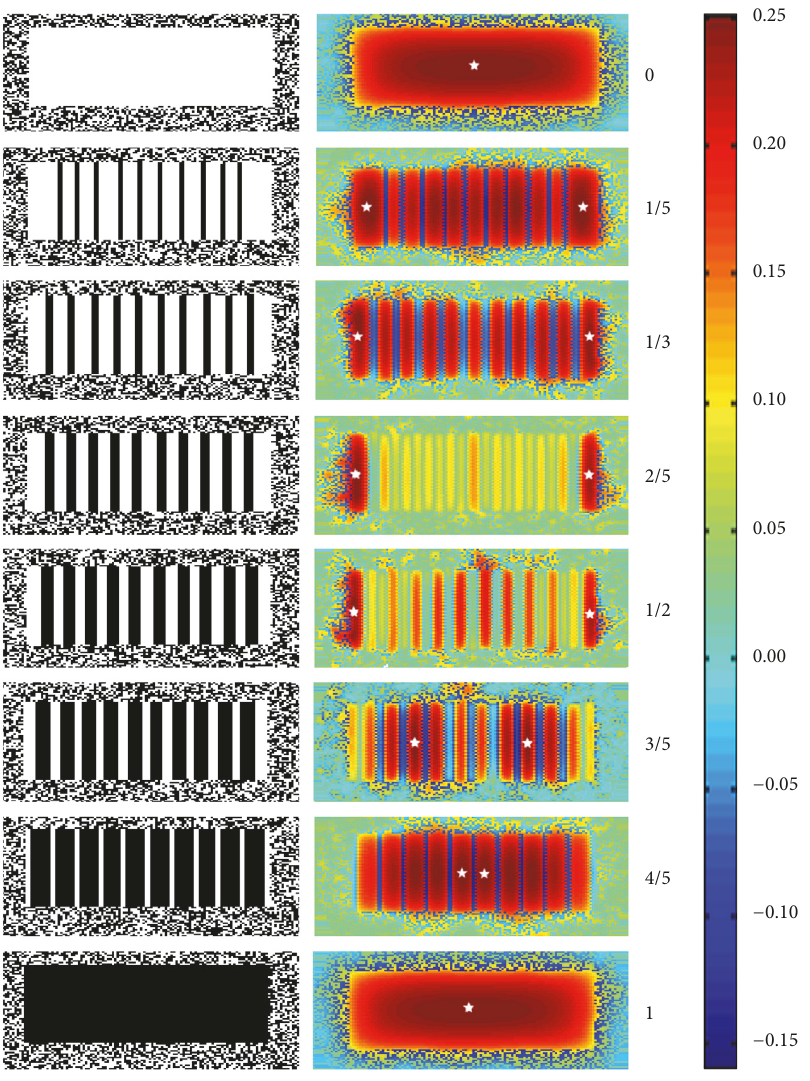
Figure 2: Progressive increase of the fraction of area 𝑥 with up magnetization. The starting point is the rectangle with 𝑥 = 0.0 , namely, the magnetization of all wires in the rectangle pointing down. The left-hand column illustrates the magnetization imposed scheme while the right-hand column gives the energy map with reddish colors marking higher repulsive energy sectors: a palette code is given to the far right. Stars indicate the positions of the wire with the highest repulsive